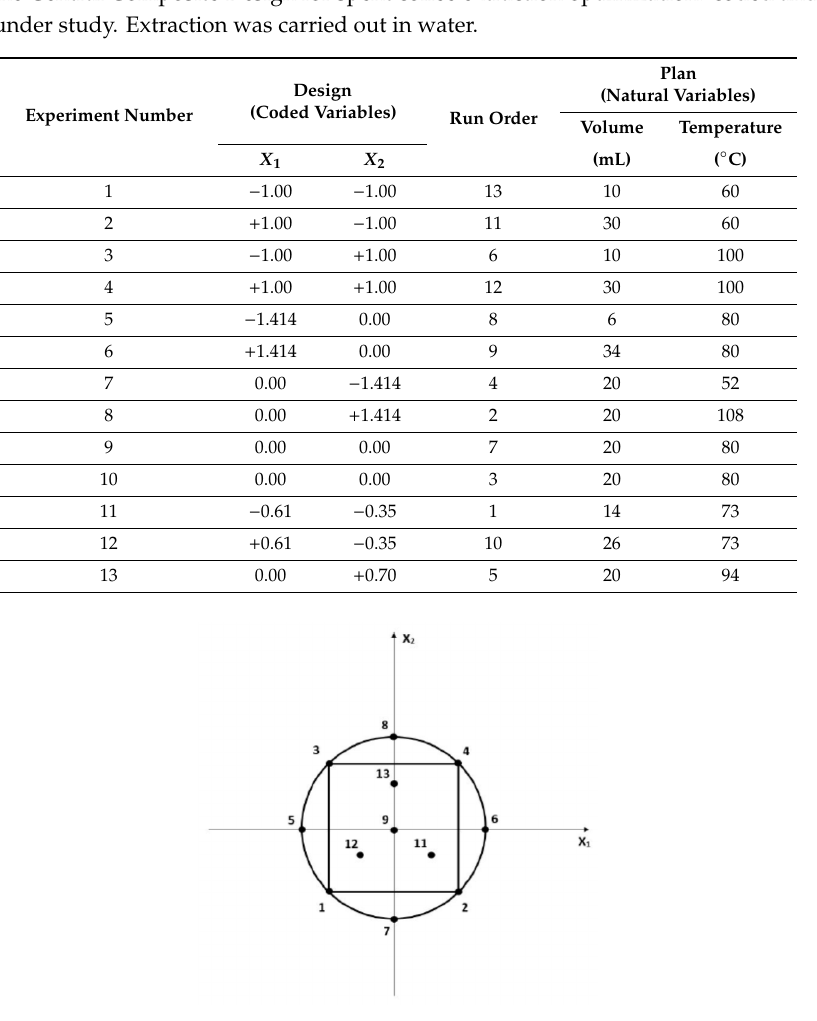
Figure 1. Graphical representation of the Central Composite Design (CCD) used for the optimization study for two variables with three check points (11–13 points) and one replicate point at the center of the experimental design (runs 9 and 10).